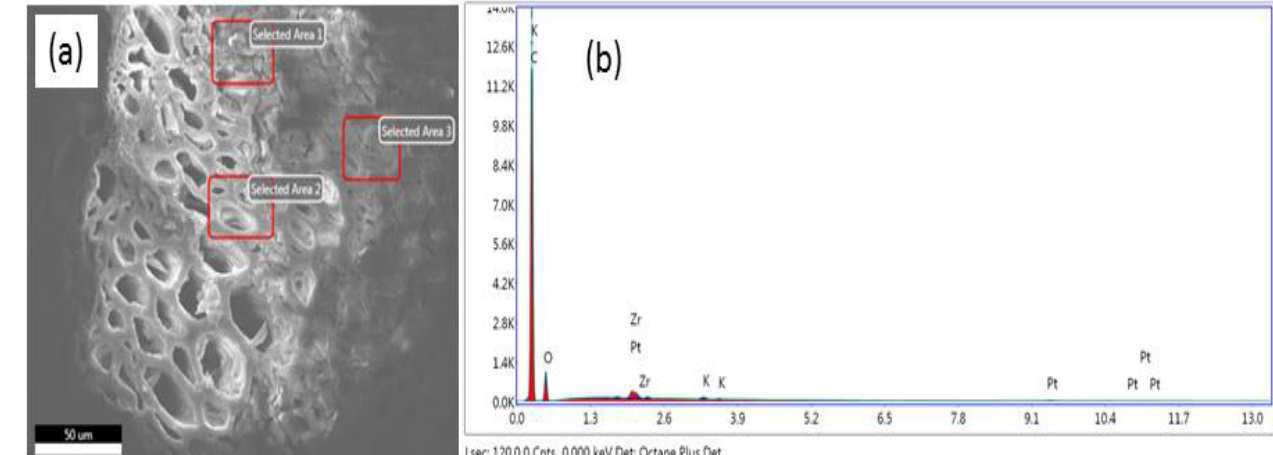
Figure 4. Arsenic accumulation and bacterial immobilization on BCXZM composite in optimized experiment. ( a ) SEM micrograph; ( b ) elementary overly of arsenic; and ( c ) EDX graph of the BCXZM composite in optimized experiment.